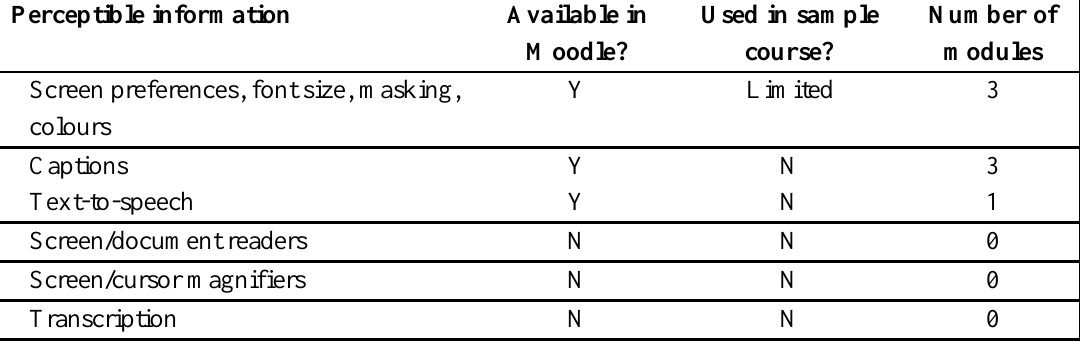
Used in sample Number of Moodle? course? modules Y